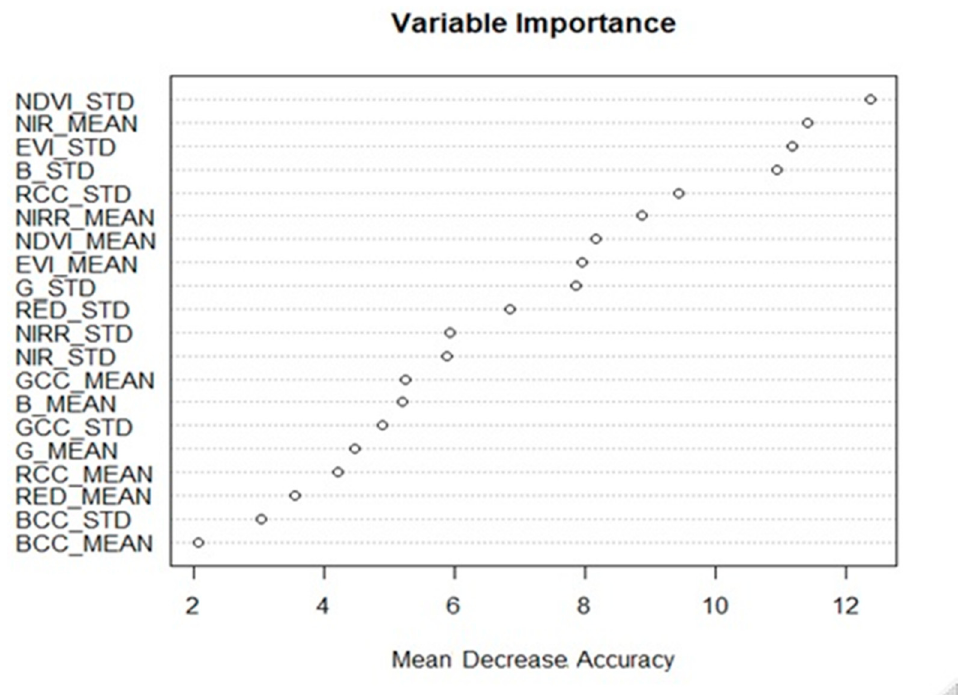
Figure 4. Graph of variable importance produced by the Random Forest model. Vertical axis values are the predictor variables and the horizontal axis shows the decrease in model accuracy if the variable is